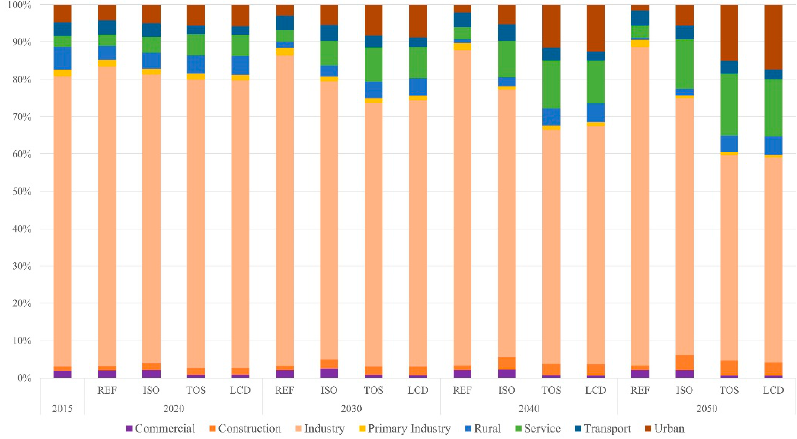
Figure 4. The proportion of the energy consumption in each sector.